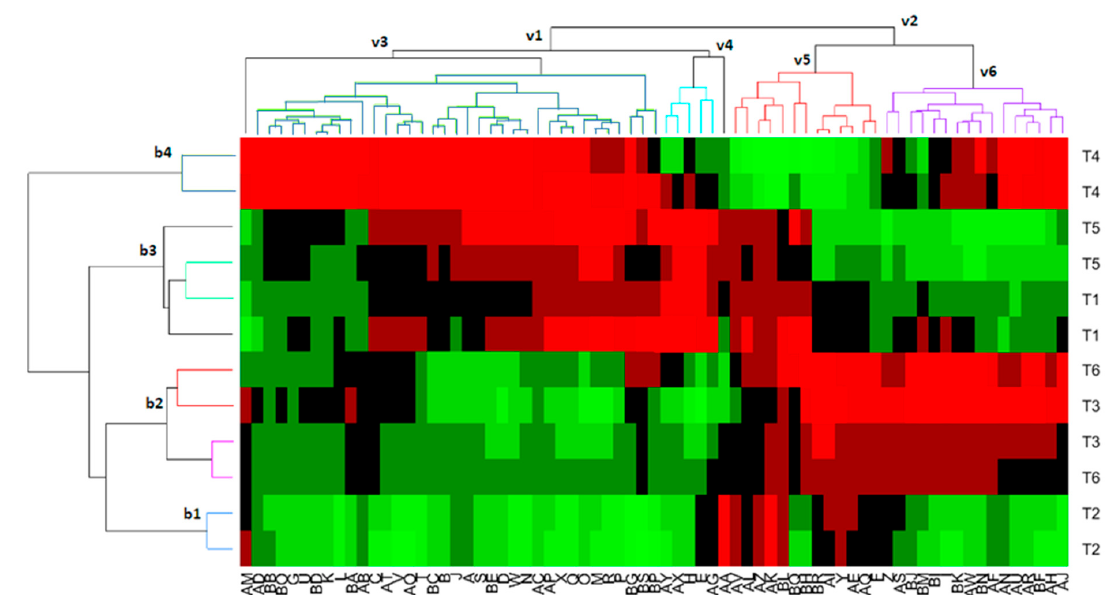
Figure 4. Bicluster plot of the relationship among treatments and VOCs. The presence of volatile is proportional to the colour scale, ranging from red (major) to green (low). See Table 2 for the meaning of the symbols for treatments and the codes of the VOCs. b1-b4 and v1-v4 refer to cluster from treatments and VOCs, respectively.